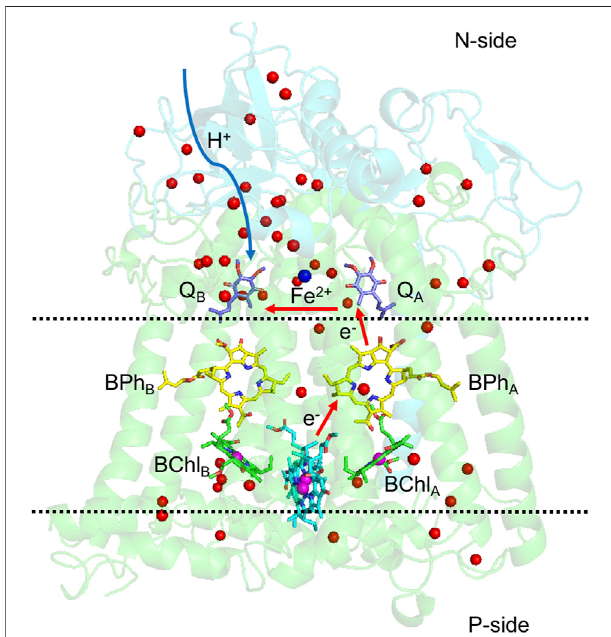
FIGURE 6 | Structure of bacterial photosynthetic reaction centers of Rhodobacter sphaeroides . L and M subunits in green, H subunit in cyan. Red arrowsfollowtheelectrontransferpath,andthebluearrowisthepathprotons travel from the N-side to Q B . Water molecules in the structure are shown as red balls. The region between the two dashed lines has few water molecules or polar residues, which discourages proton transfer across the protein. The two quinones are still within the lipid membrane, but in a region of the protein with multiple polar residues and water molecules to transport protons. Coordinates are from PDB ID: 1AIG.